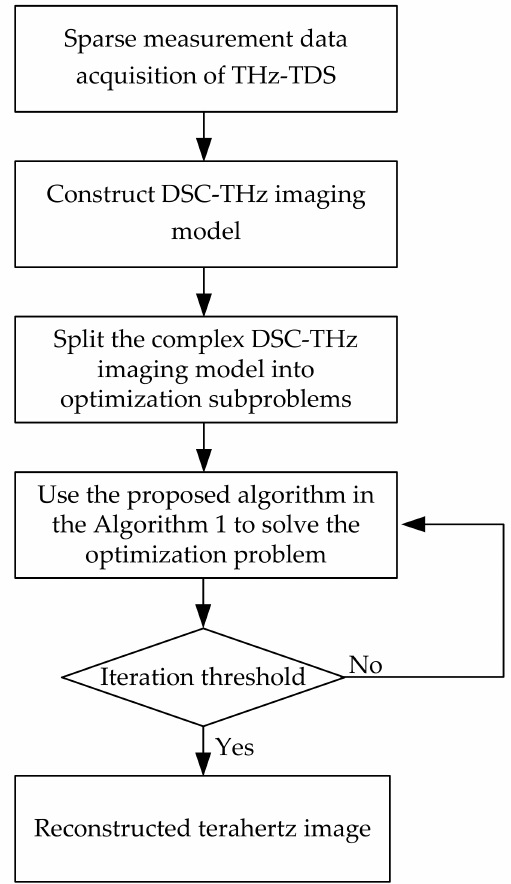
Figure 2. The processing flow of the proposed spatial domain terahertz image reconstruction